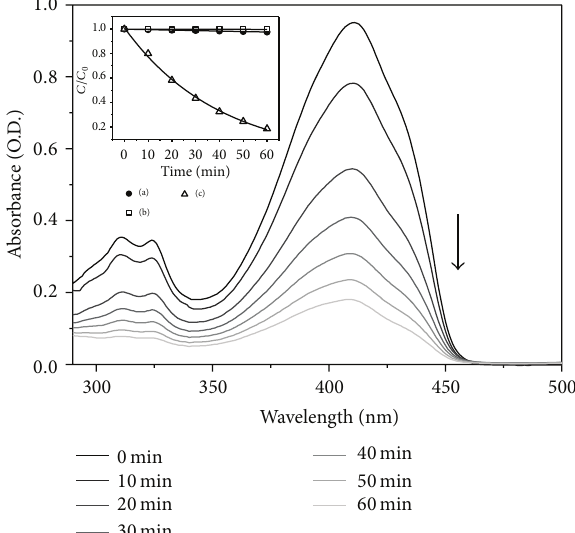
alloy plate are observed at 576.8, 580.0, and 586.2 eV and these